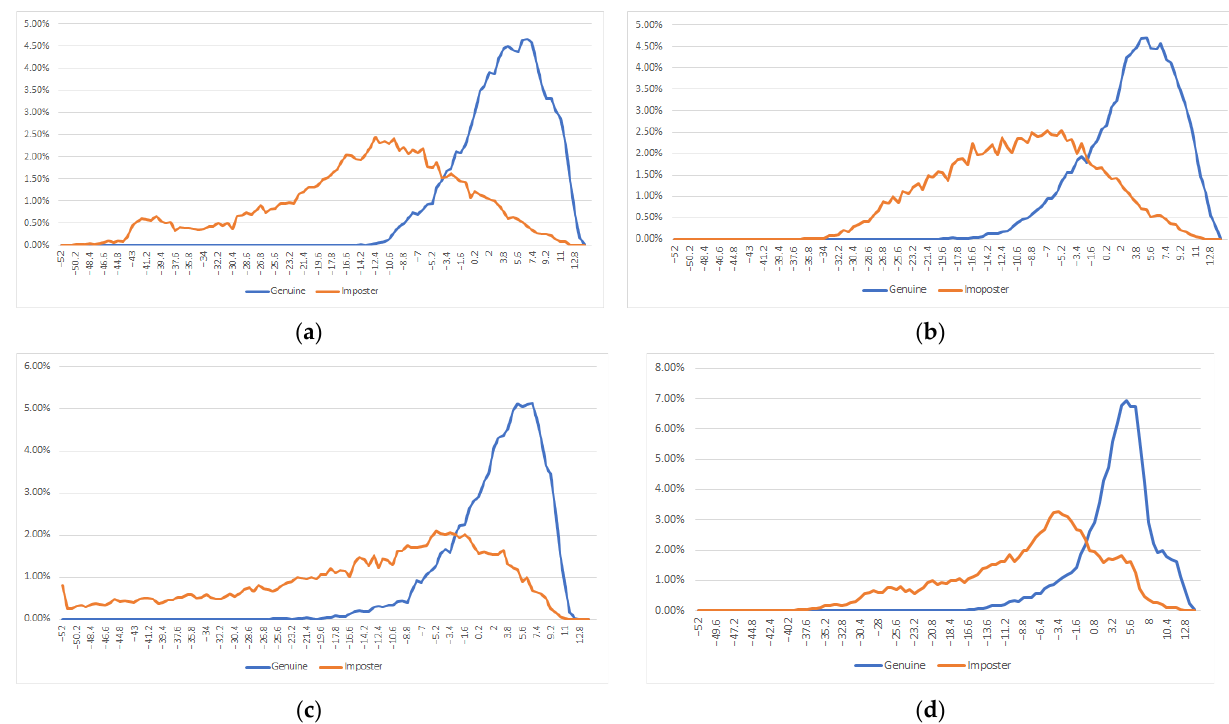
Figure 5. Probability density functions for genuine/imposter matching of four characters: ( a ) ‘ 없 ’ ; ( b ) ‘ 김 ’ ; ( c ) ‘ 다 ’ ; ( d ) ‘ 이’ . The combined predicted values were verified using a support vector machine (SVM)